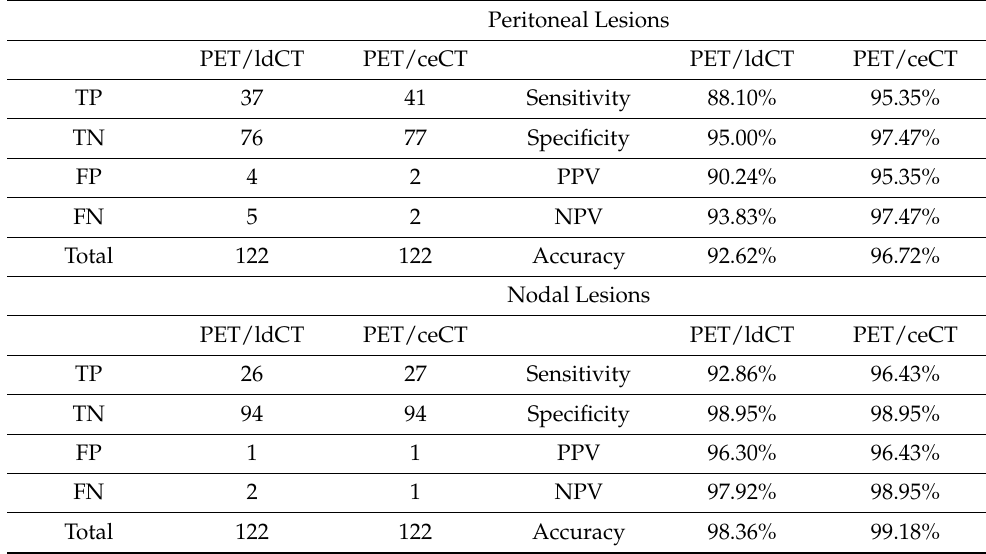
Table 3. Per-patient analysis of the two diagnostic